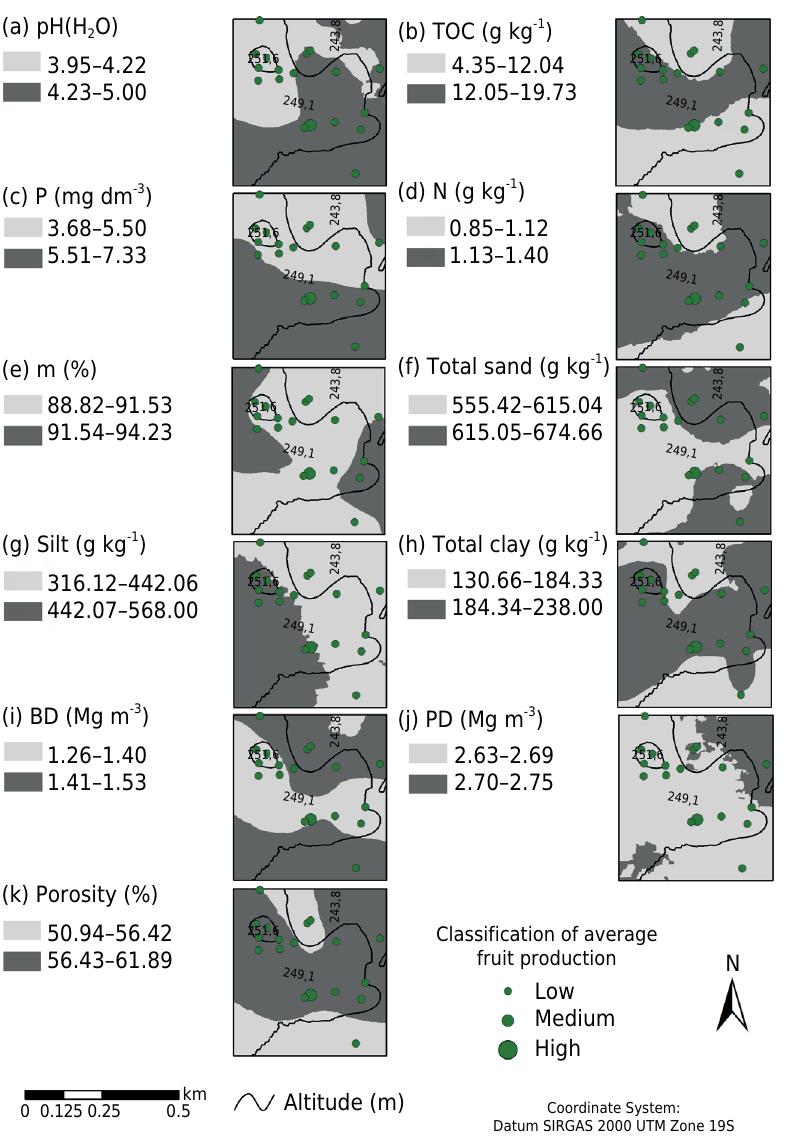
Figure 6. Spatial distribution of soil physical and chemical properties in Filipinas - Plot 1, in the state of Acre, Brazil. Lines and values in the maps correspond to the altitude of the area, circles correspond to the average fruit production between the years 2010 and 2020, and values presented in the legends are the soil